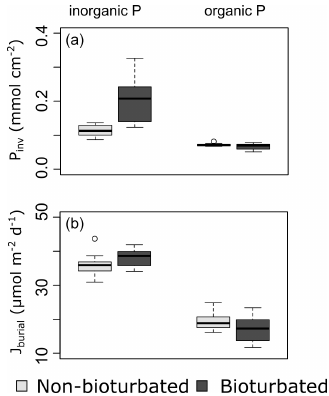
Figure 3. Boxplots of (a) inventories and (b) burial rates of inor- ganic and organic P fractions. The data of 2015 are not included in (a) , since some depth samples were not analysed for P fractiona-